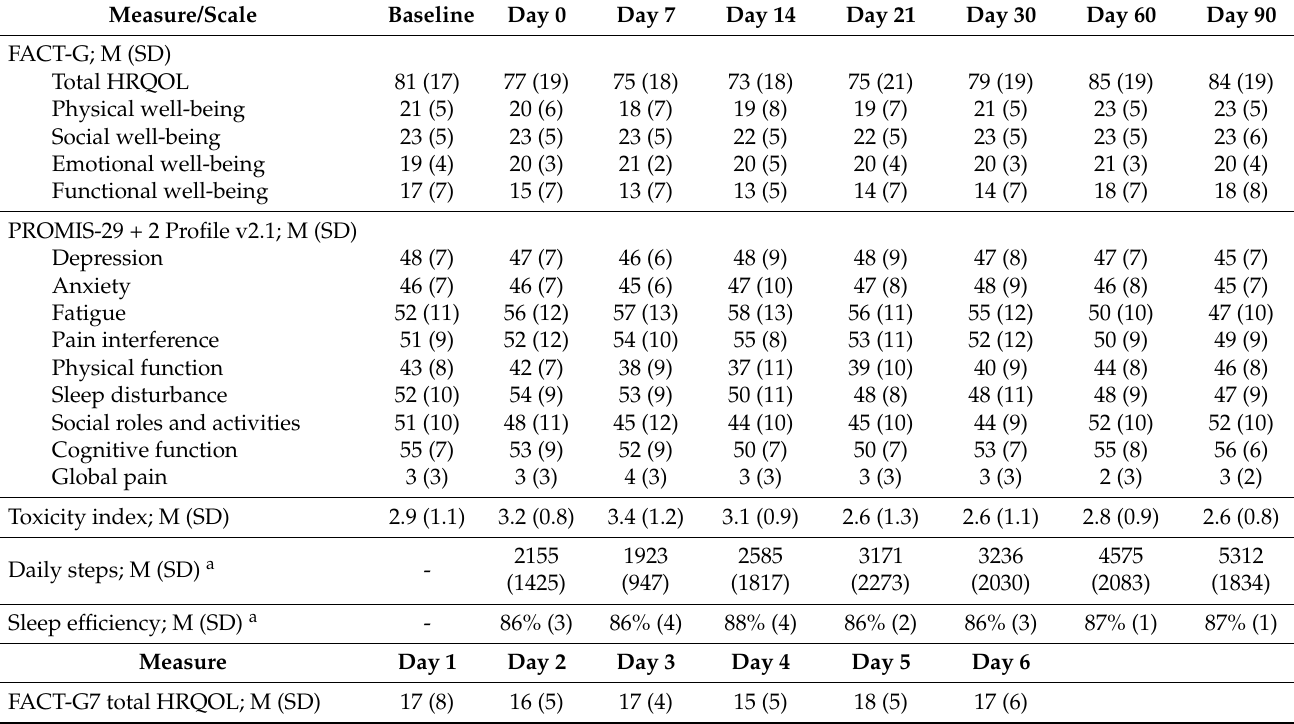
Table 3. Descriptive statistics of HRQOL, toxicity burden, and activity data across time (N =